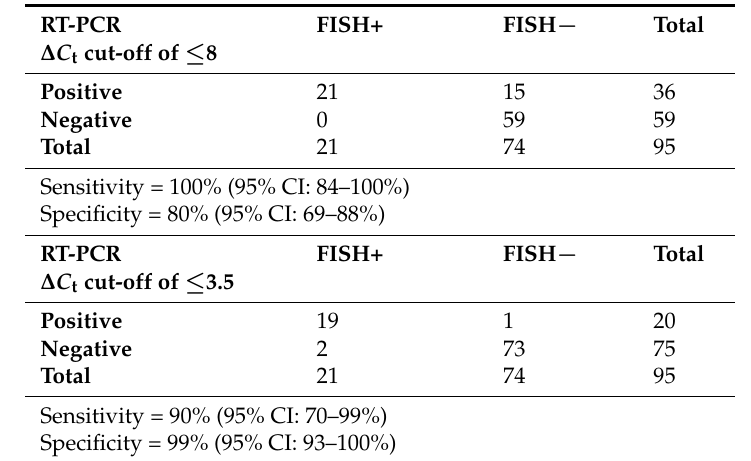
Table 3. Sensitivity and specificity of RT-PCR using ∆ C t ≤ 8 and ∆ C t ≤ 3.5 with FISH as the reference standard for detecting ALK rearrangements.